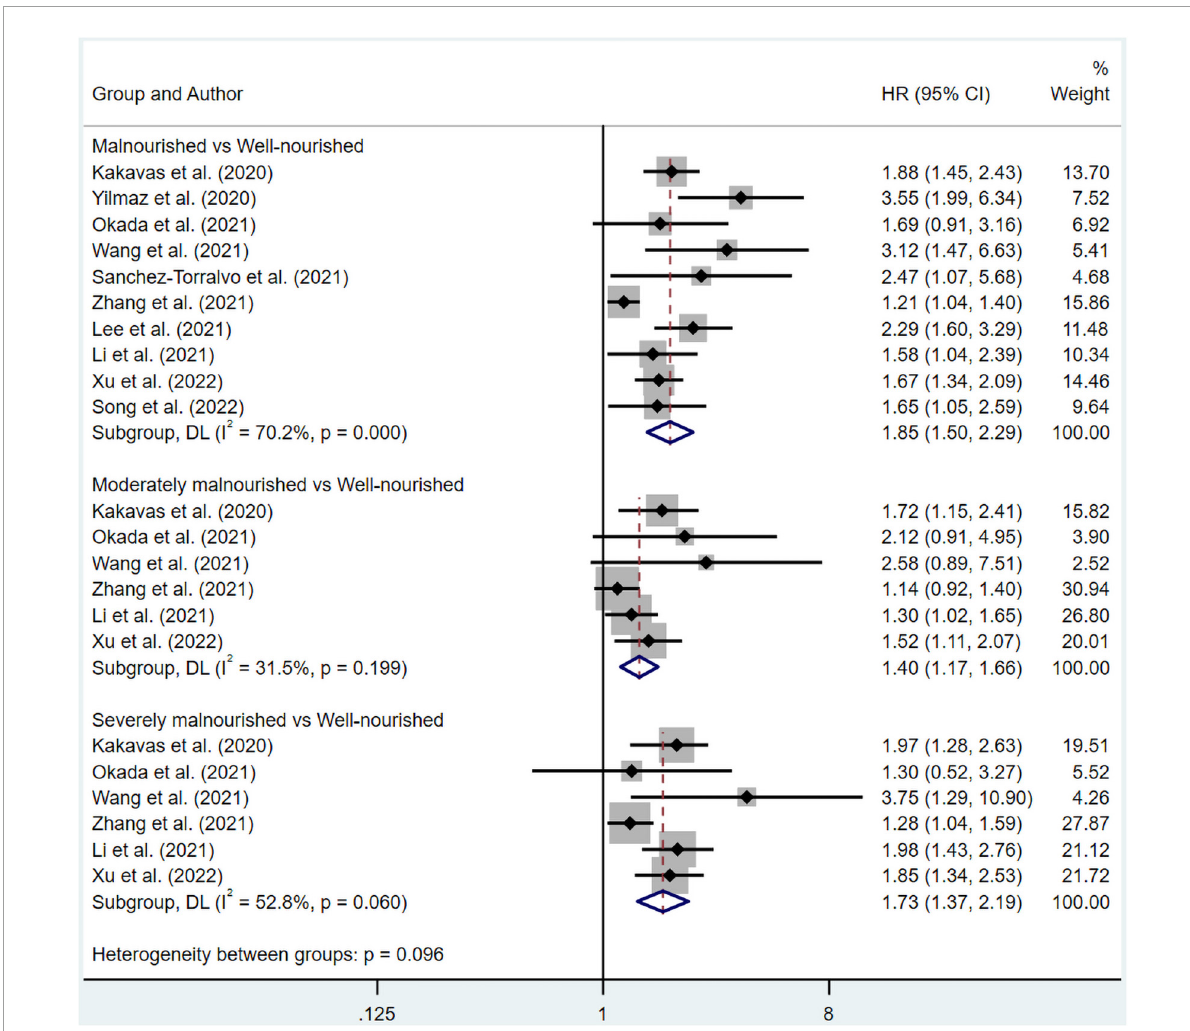
FIGURE2 Forest plots showing pooled HR with 95% CI of overall survival under multivariate regression model. X-axis indicated hazard ratio (HR). Weights and between-subgroup heterogeneity test are from random-effects